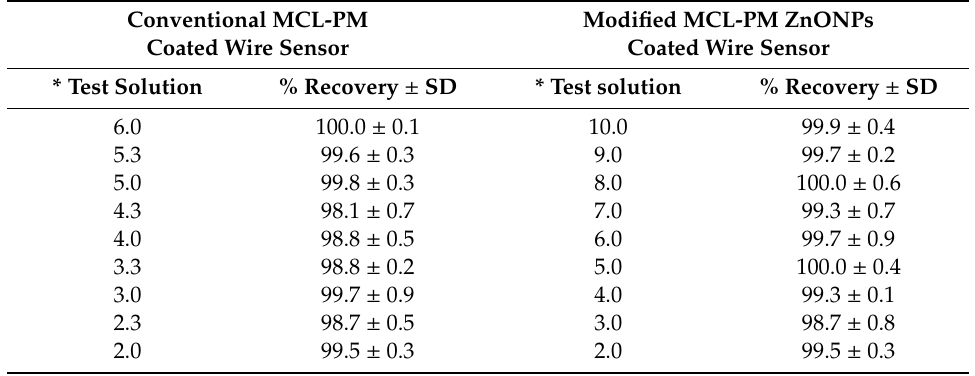
Table 3. Statistical analysis of data obtained from the determination of MCL in bulk powder using conventional MCL-PM and modified MCL-PM-ZnONPs-coated wire